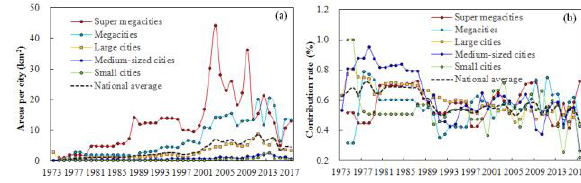
Figure 5. Cultivated land losses in different population-size cities (a) annual occupied area per city; (b) contribution rate